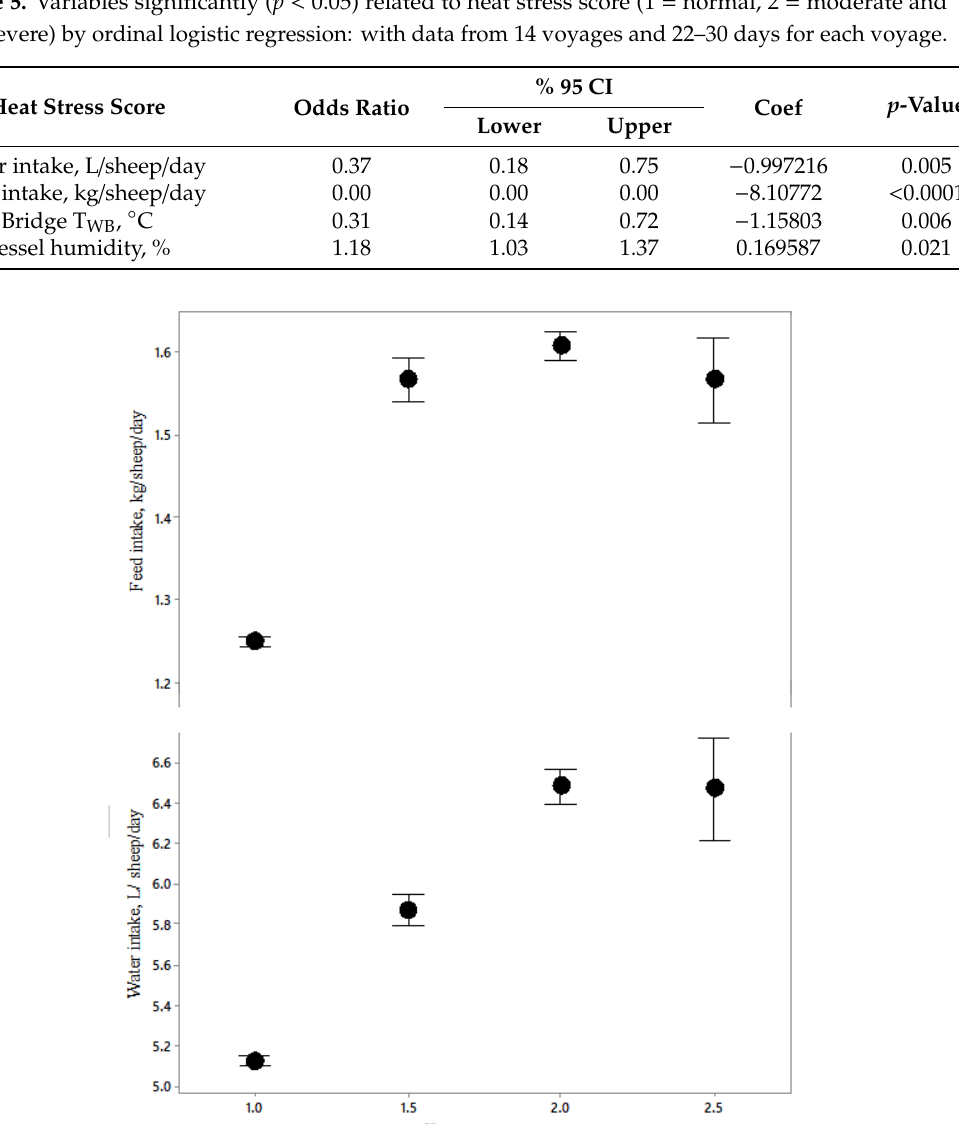
Table 4. Variables significantly ( p < 0.05) related to heat stress score (1 = normal, 2 = moderate and 3 = severe) by ordinal logistic regression: with data from 14 voyages and 22 – 30 days for each voyage.